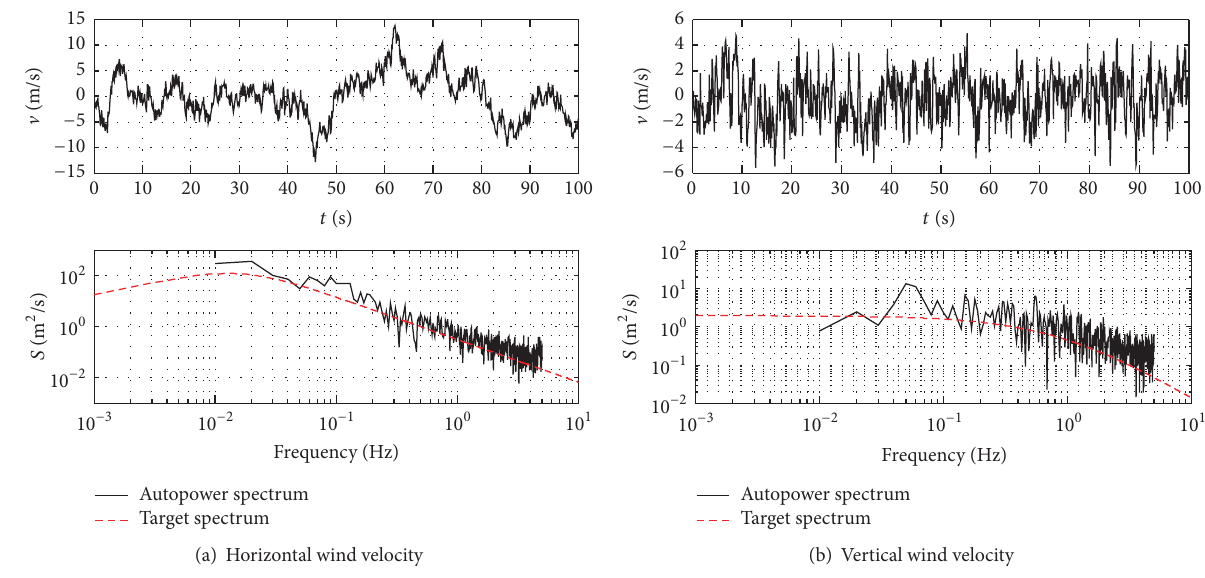
Figure 7: Simulation results of fluctuating wind velocity and their power